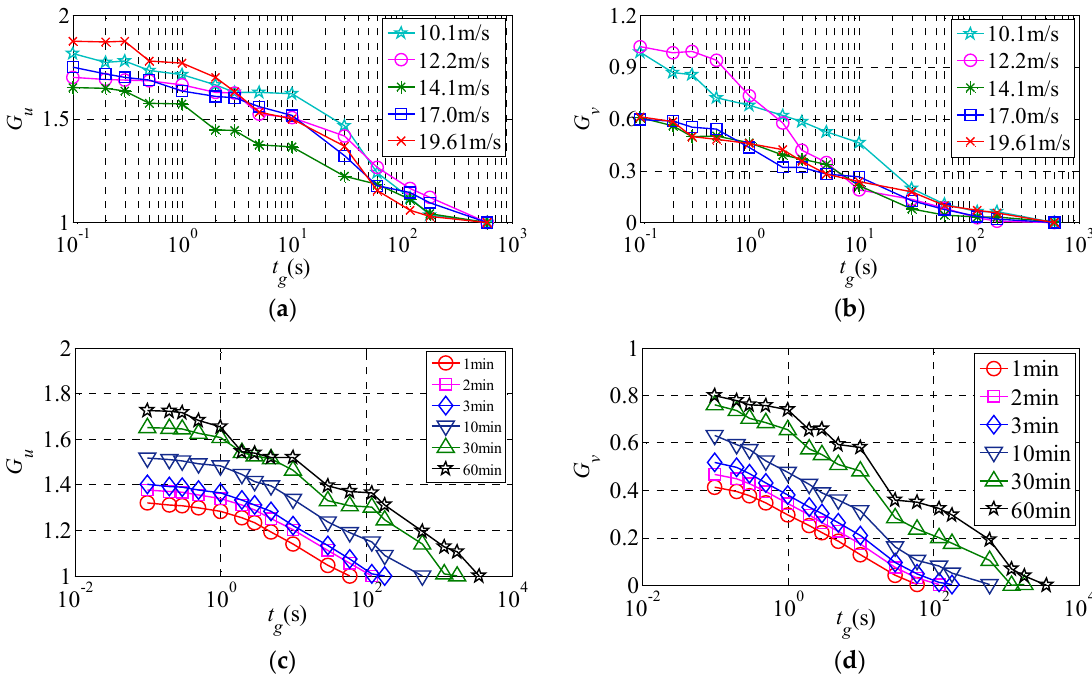
Figure 11. The variation of gust factors obtained at different sample duration and gust duration. ( a ) G u with respect to t g ; ( b ) G v with respect to t g ; ( c ) G u with respect to T ; ( d ) G v with respect to T.